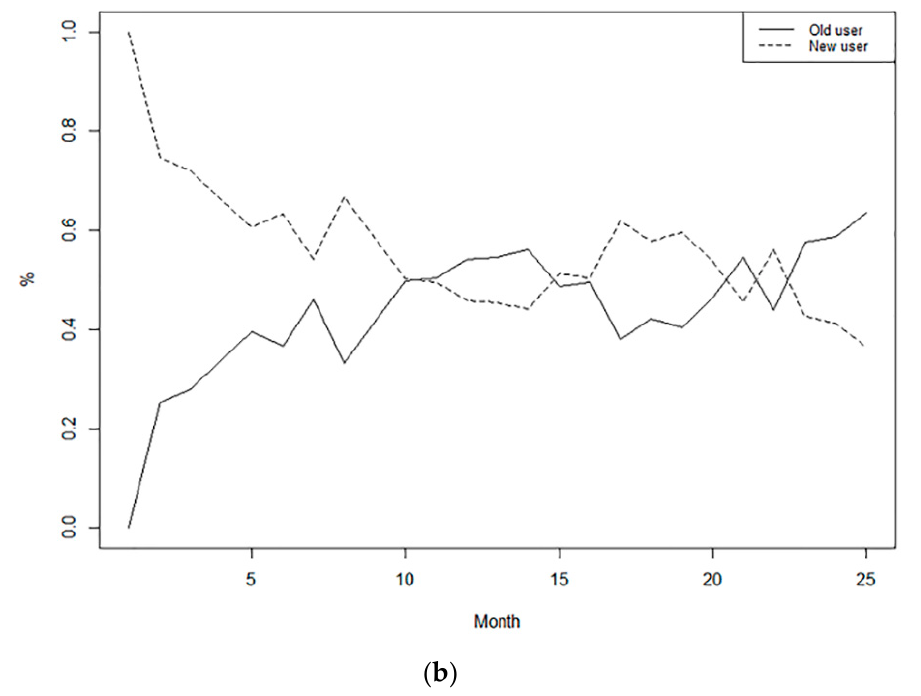
Figure 3. ( a ): Change in the number of users. ( b ): Change in the composition of users.